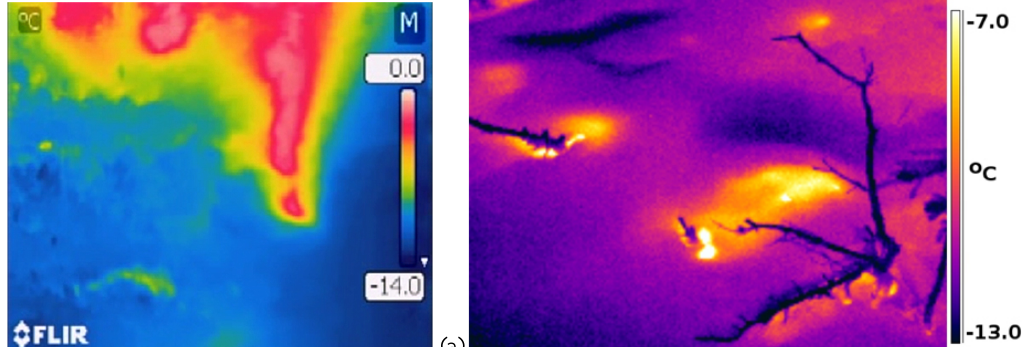
Fig. 8. Two different types of heat penetration into snow. (a) A video frame of fingers of melt penetrating the surface of the snow after 20min of heating. The fingers are up to 6cm long. (b) Hibernating bushes are cold above the snow, but still transport heat from the ground to warm the snow from below. The image spans ∼